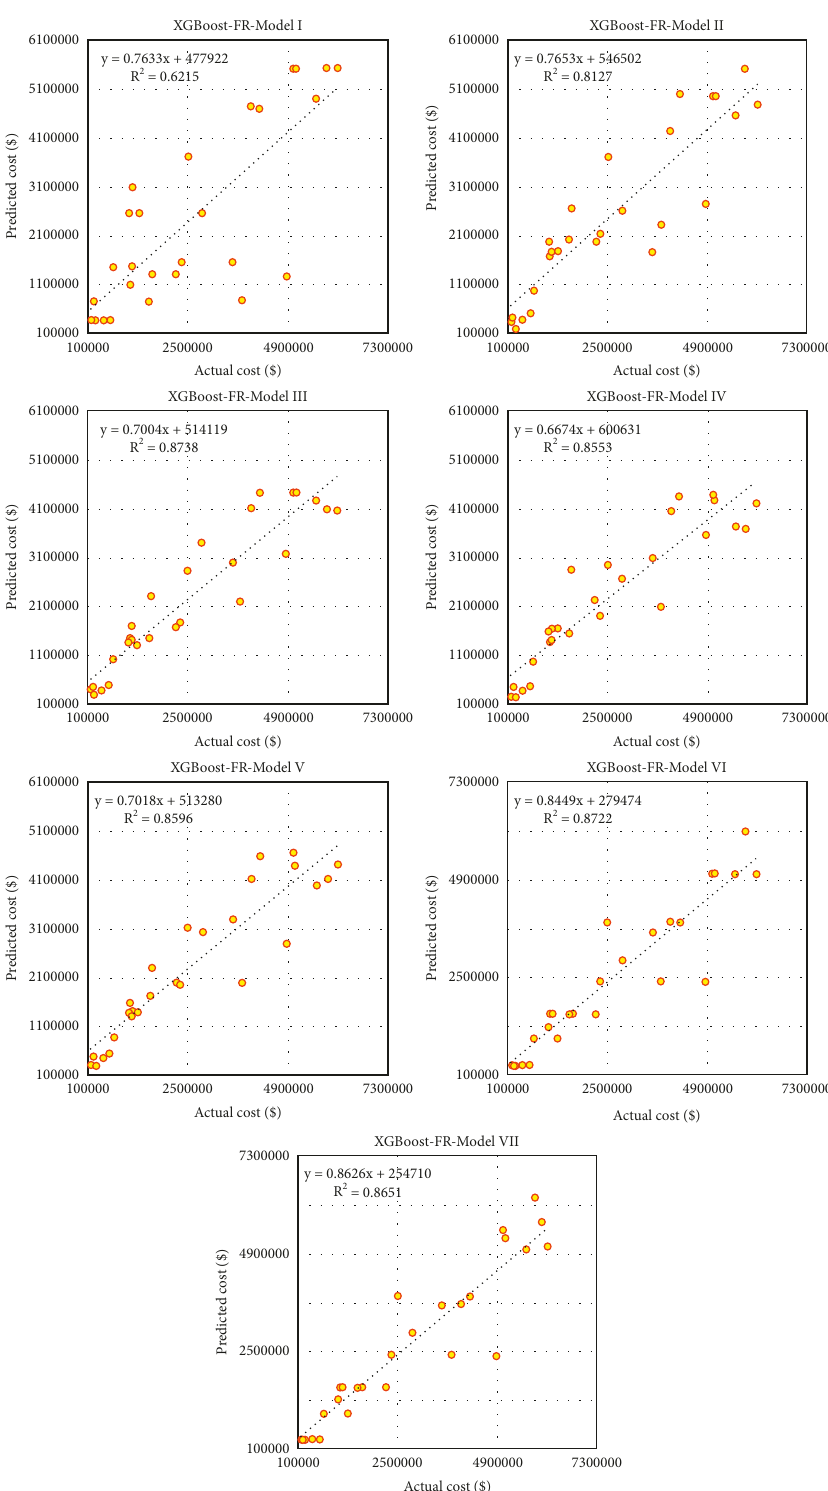
Figure 6: Scatter plot presentation of the XGBoost-RF model for tested